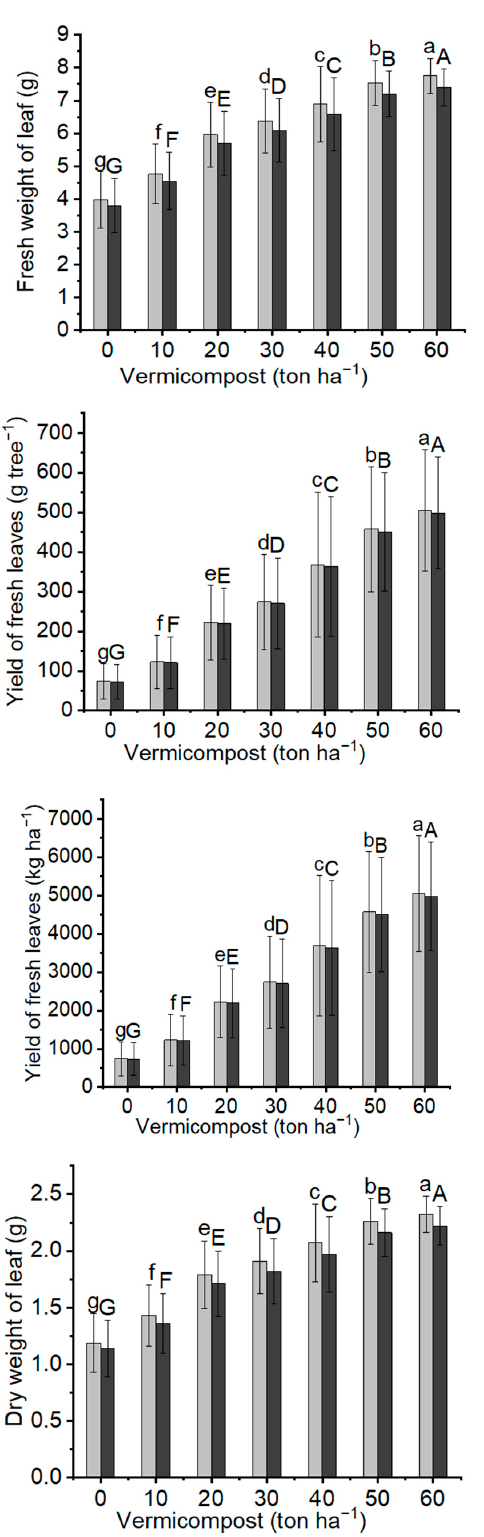
Figure 2. In both seasons of the study, the mean values of fresh weight of leaves (g), yield of fresh leaves (g tree − 1 ), yield of fresh leaves (kg ha − 1 ), and dry weight of leaf (g) of Moringa oleifera trees as influenced by vermicompost and NPK fertilization are provided below. The data are presented as a mean with standard error ( n = 3). Bars with identical lowercase letters are not significant at the 0.05 level of